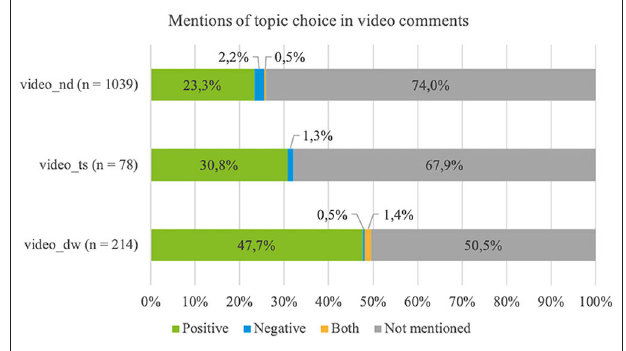
FIGURE 2 | Categorization of viewer’s comments on the three case study videos with respect to the topic choice.